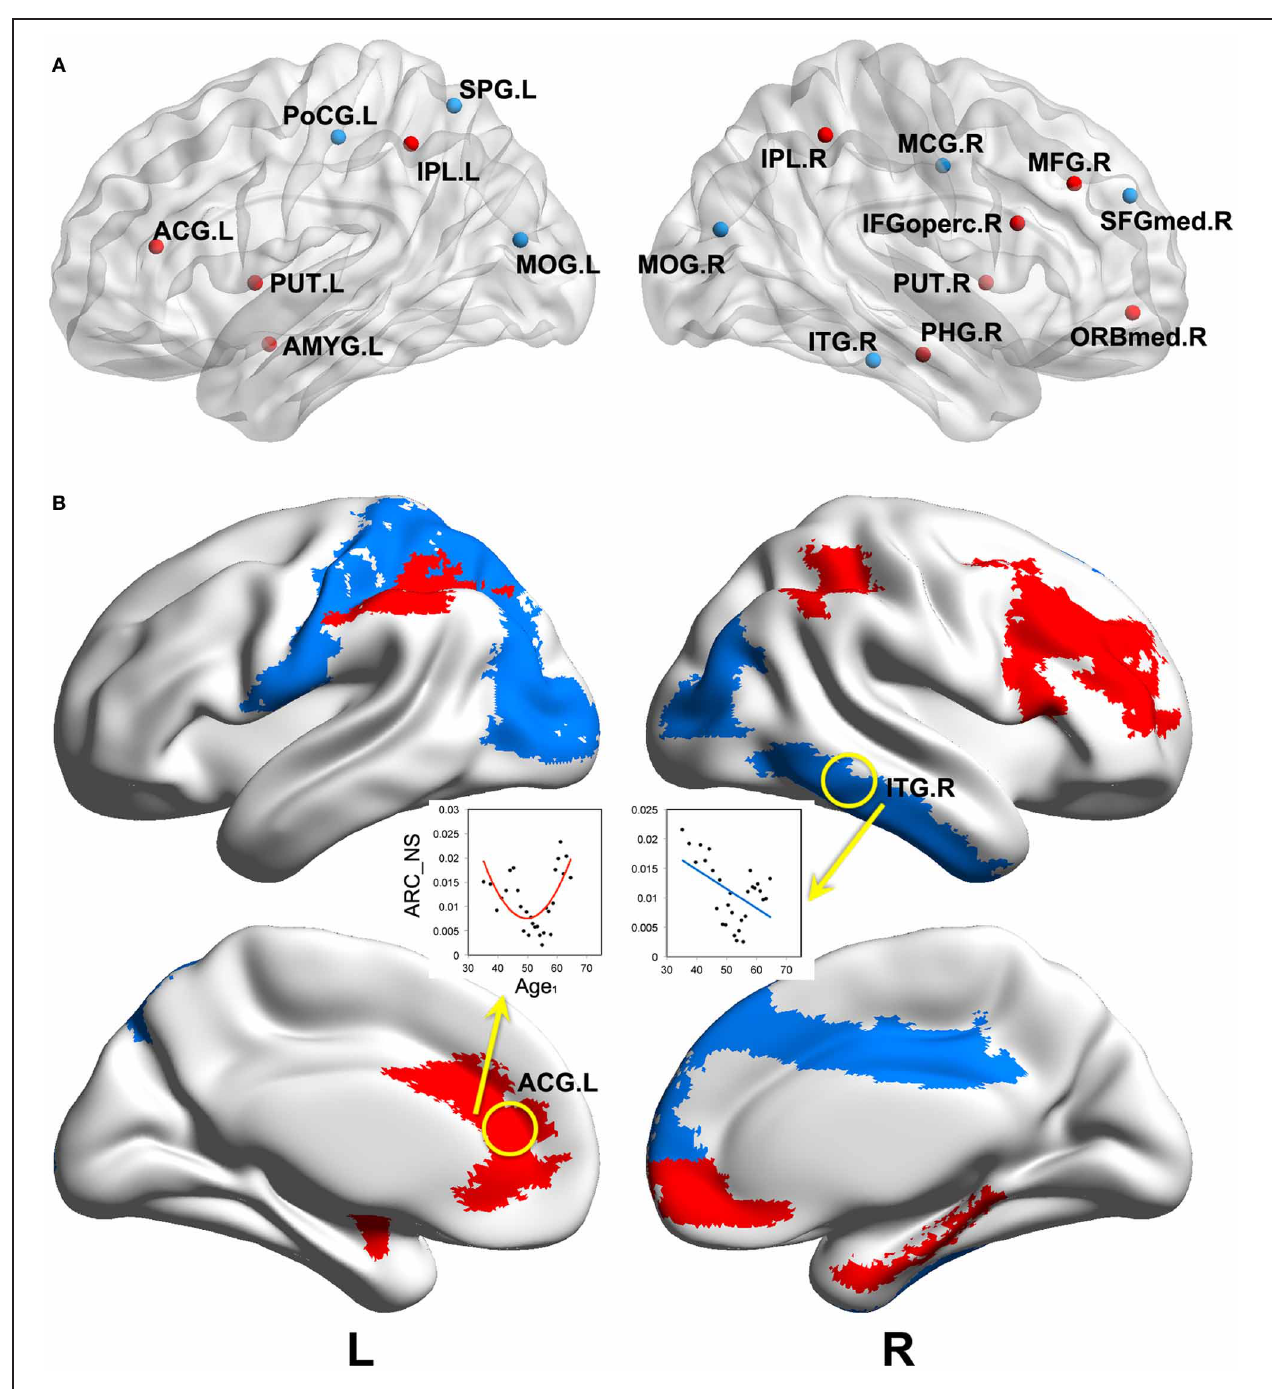
FIGURE 4 | Significant correlations between the annual rate of change in node strength and the baseline age. Significant correlations ( p < 0 . 05) are visualized in anatomical space (A) and mapped onto the cortical surface (B) .